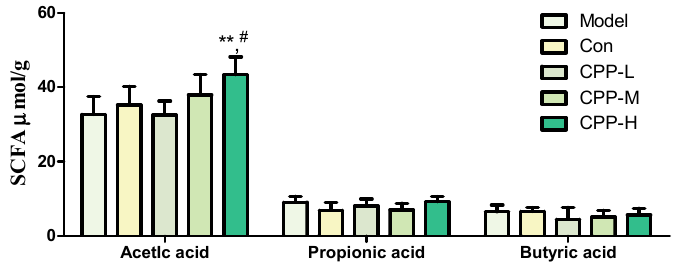
Figure 3. Effects of CPP on SCFA level in cyclophosphamide-treated mice. Model, model control; Con, normal control; CPP-L, 50 mg/kg bodyweight CPP treated group; CPP-M, 100 mg/kg bodyweight CPP treated group; CPP-H, 200 mg/kg bodyweight CPP treated group. The values were presented as mean ± SD. ** p < 0.01, compared with model group; # p < 0.05, compared with normal group.